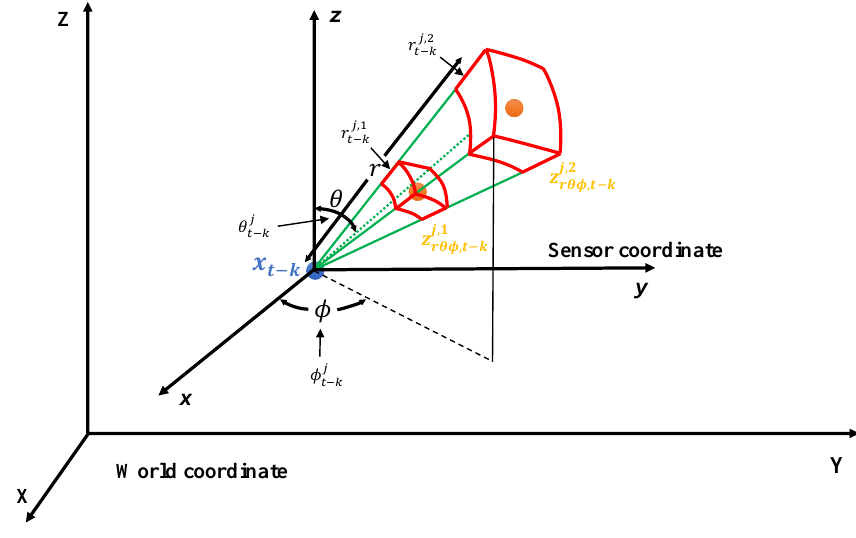
Figure 5. Likelihood field for the point z i , m of the beam